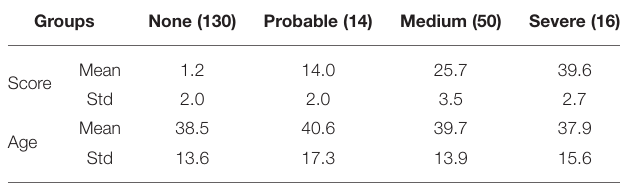
TABLE 2 | Age and HAM-D score in the multi-classes